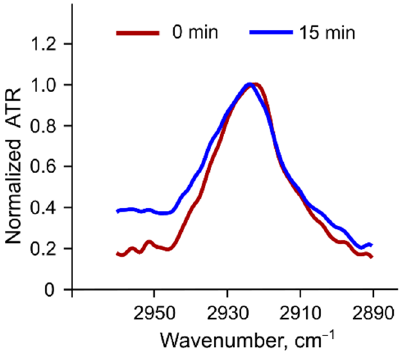
Figure 9. Normalized asymmetric stretching vibrations peak in the 10CMG liposomes before (red) and after albumin addition (blue). FTIR spectra were recorded in PBS at 37 ◦ C, lipid concentration of 12 mM, and albumin concentration of 6 mg/mL.